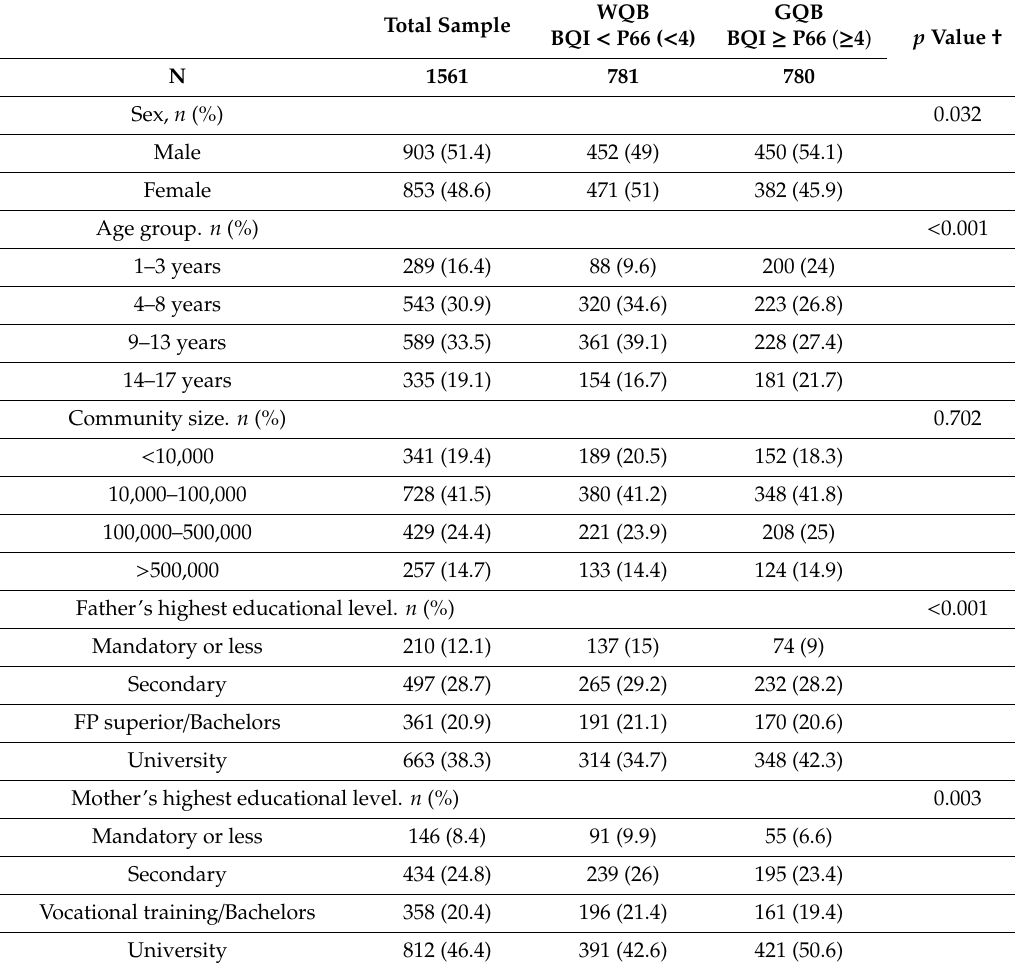
Table 6. Characteristics of children aged 1 to 17 y, by breakfast quality ( n = 1561). WQB Total Sample BQI < P66 ( < 4)